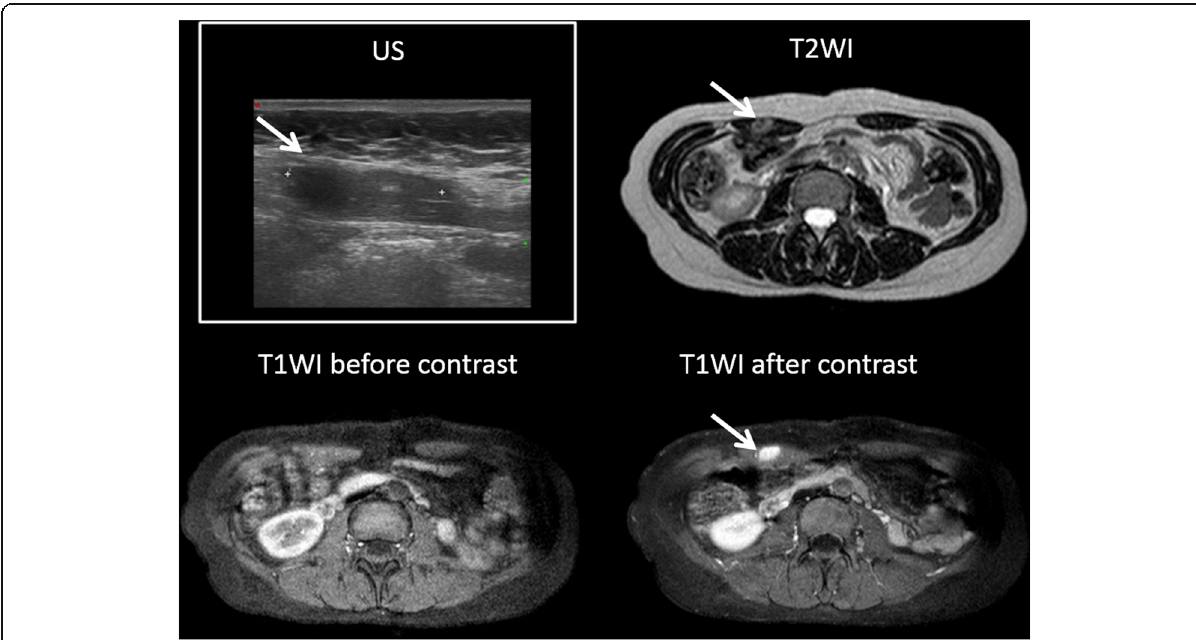
Fig. 13 Desmoid tumor (white arrow) appears as homogeneously hypoechoic masses at US examination. On MR, typical signal characteristics include T1-WI and T2-WI low signal intensity and variable contrast enhancement (homogeneous in this case)